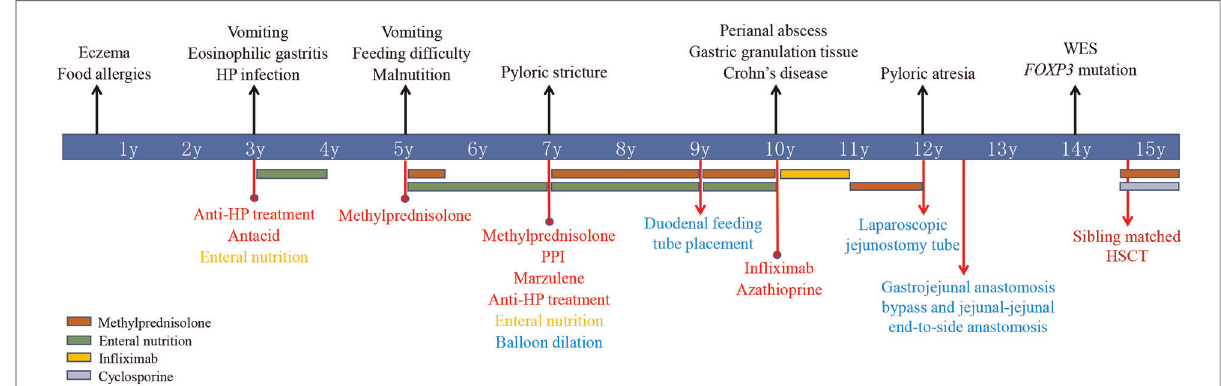
FIGURE 1 Timeline of clinical events, diagnostics, and treatments of the patient. FOXP3 , forkhead box protein 3; WES, whole-exome sequencing; HP, Helicobacter pylori ; PPI, proton pump inhibitors; HSCT, hematopoietic stem cell